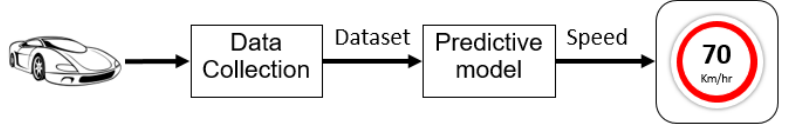
Figure 6. The graphic diagram of the two parts required to develop this work.